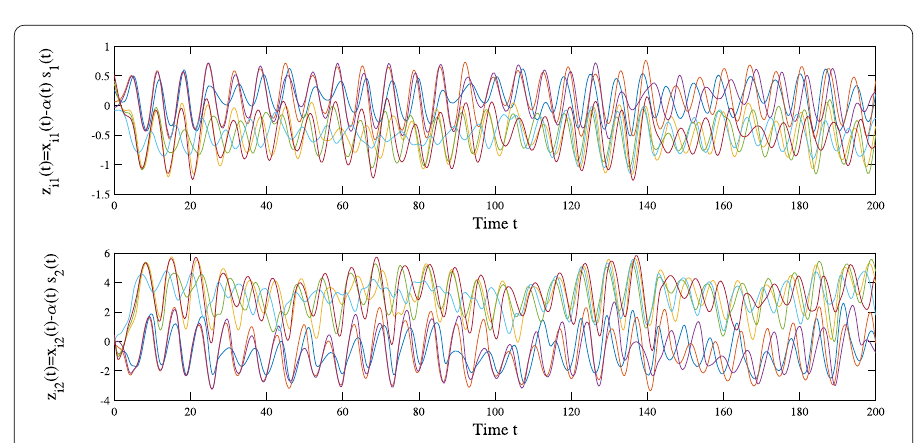
Figure 6 The EFPS error between isolate node α ( t ) s ( t ) (42) and network x i ( t ) (1) without sample-data pinning control